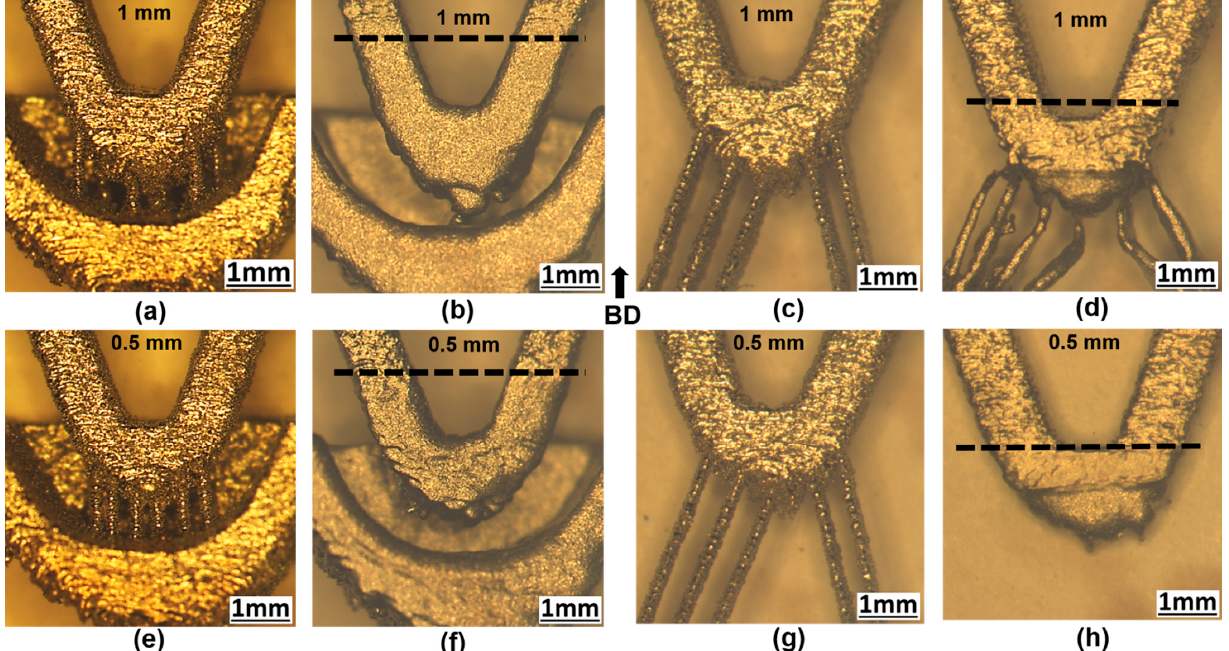
Figure 13. Light microscopy images depicting the influence of GB on the removal of support structures manufactured using strut thickness of ( a – d ) 1 mm and ( e – h ) 0.5 mm; for strut thickness of 1 mm, specimens fabricated using ( a , b ) cross support and ( c , d ) line support; specimens before ( a , c ) and after ( b , d ) GB; for strut thickness of 0.5 mm, specimens fabricated using ( e , f ) cross support and ( g , h ) line support, specimens before ( e , g ) and after ( f , h ) GB. Strut thicknesses are mentioned in each image together with the location of shield plate delineated using black dotted lines.